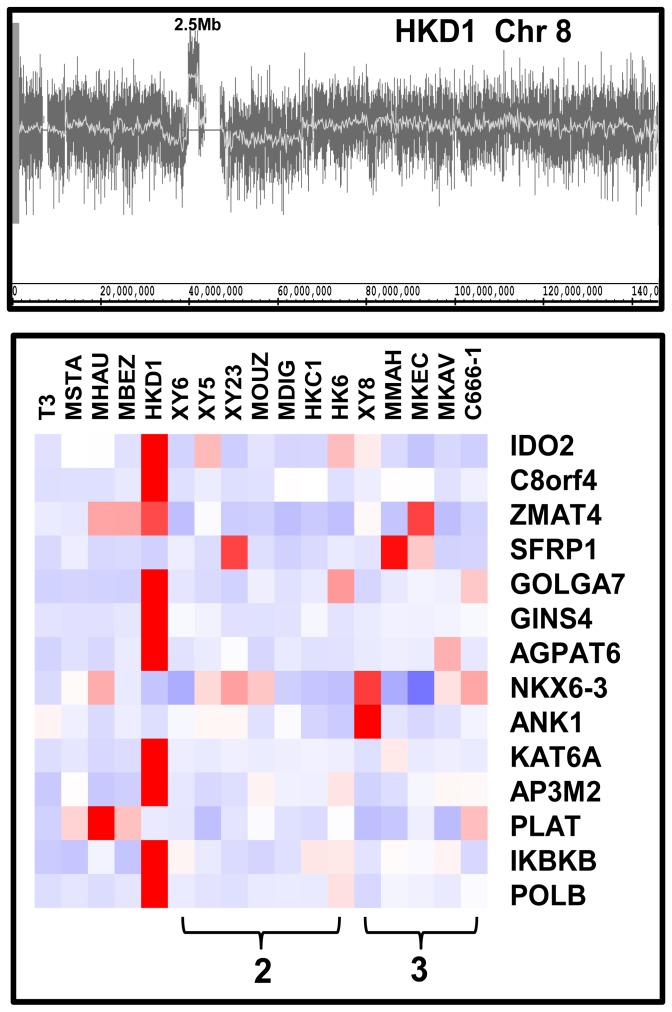
The 8p11.21 amplified region of tumour HKD1.A. Trace of the log2 ratio of the copy number of DNA from the tumour sample compared to the normal controls. The 2.5 Mb amplification is indicated. B. Heat map of the relative expression levels of the genes found within the amplified region. The samples appear in columns and the individual genes within the amplified region form the rows. High level expression is represented by the intensity of red and low level by blue. The brackets at the bottom indicate tumour samples with genome copy numbers of 2 or 3 within this region.